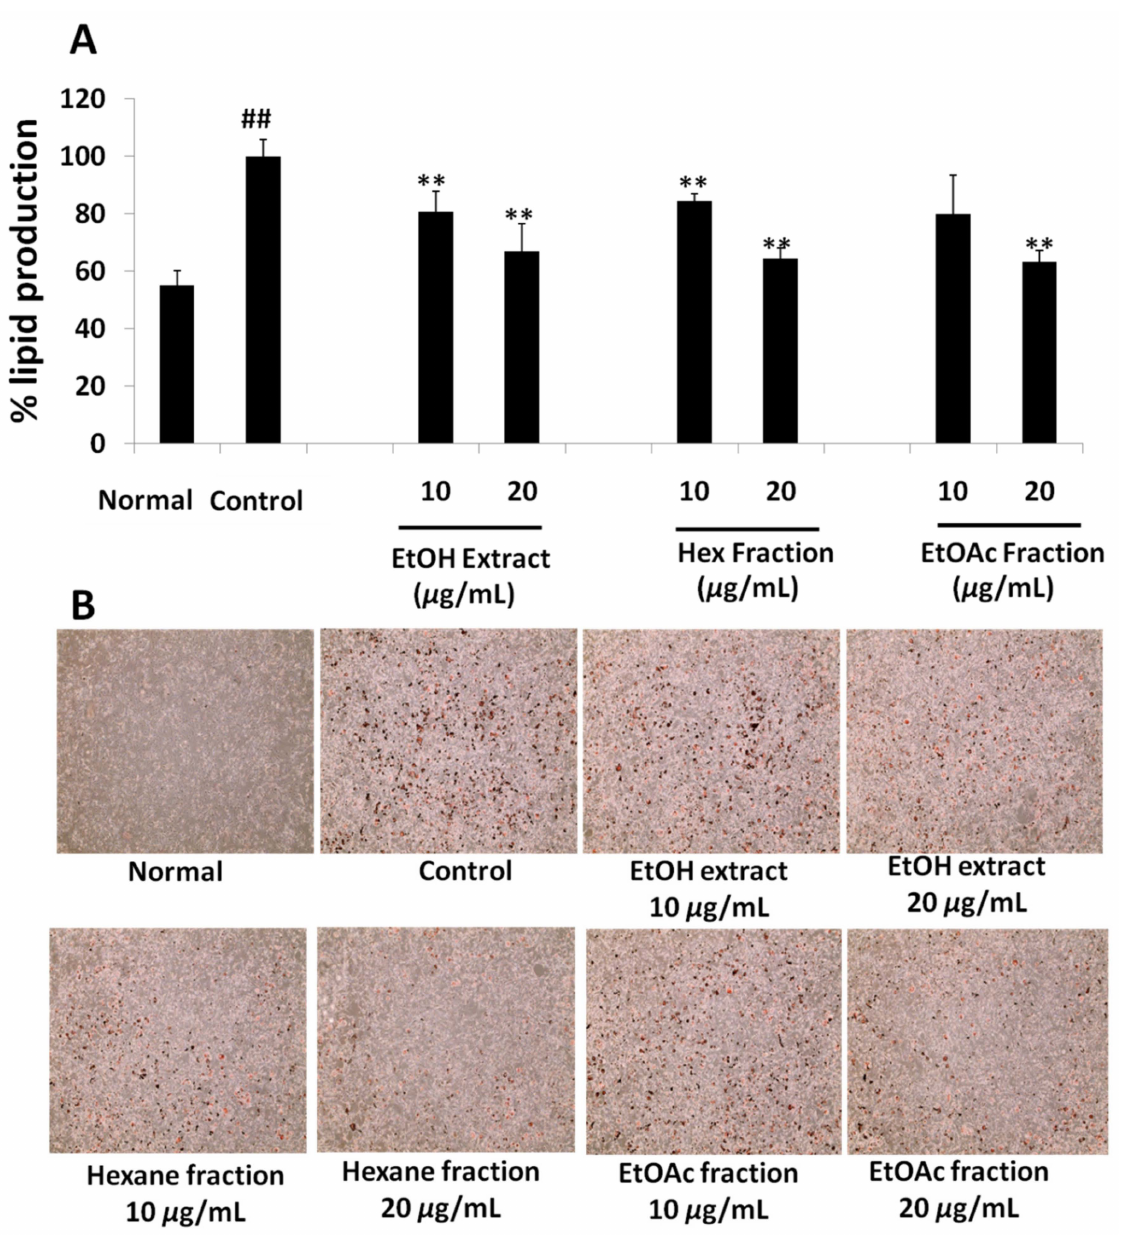
Figure 5. ( A ) Effect of ethanol extracts, hexane fraction and ethyl acetate fraction on percentage lipid deposition by 3T3-L1 cells using ORO assay. ( B )Lipid accumulation in 3T3-L1 cell observed by EVOS XL microscope at 10 × magnification after ORO staining. Each set of data represents mean of triplicate experiment ± standard deviation. Significant difference between the groups was calculated using two-tailed Student’s t -test. ** p < 0.01 vs. control, ## p < 0.01 vs. normal are used to represent significant difference in lipid production of the sample compared to non-treated control